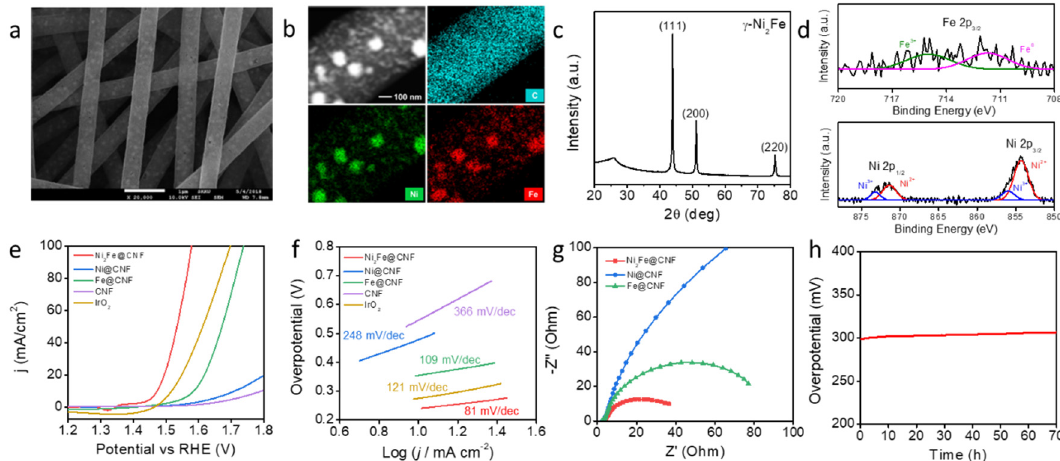
Figure 3. Ni 2 Fe@CNF for the OER electrode. ( a ) SEM images, ( b ) EDS elemental maps, ( c ) XRD pattern, and ( d ) XPS analysis of Ni 2 Fe@CNF. ( e ) Polarization curves of the Ni 2 Fe@CNF,